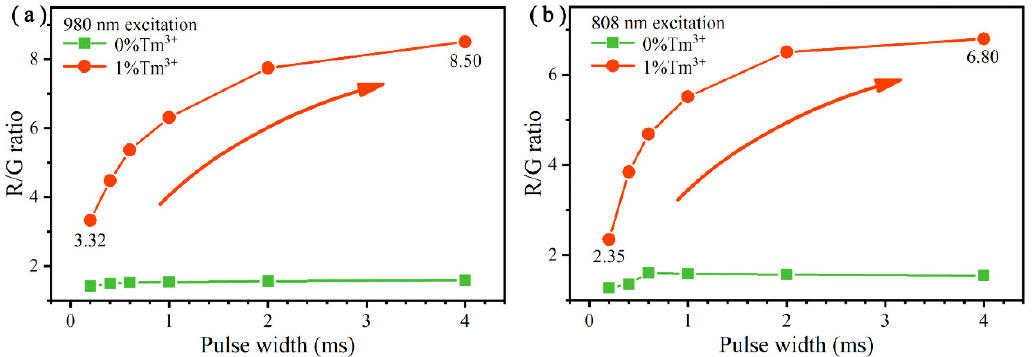
Figure 8. ( a ) R / G ratios of the Y 2 O 3 :Er 3 + / Tm 3 + (8 / x mol%) UCNPs under the excitation of a 980 nm Figure 8. ( a ) R/G ratios of the Y 2 O 3 :Er 3+ /Tm 3+ (8/ x mol%) UCNPs under the excitation of a 980 nm laser operated at di ff erent excitation pulse-width, x = 0 and 1. ( b ) R / G ratios of the Y 2 O 3 :Er 3 + / Tm 3 + laser operated at different excitation pulse-width, x = 0 and 1. ( b ) R/G ratios of the Y 2 O 3 :Er 3+ /Tm 3+ (8/ x (8 / x mol%) UCNPs under the excitation of 808 nm laser operated at di ff erent excitation pulse-width, mol%) UCNPs under the excitation of 808 nm laser operated at different excitation pulse-width, x = 0 x = 0 and and 1.